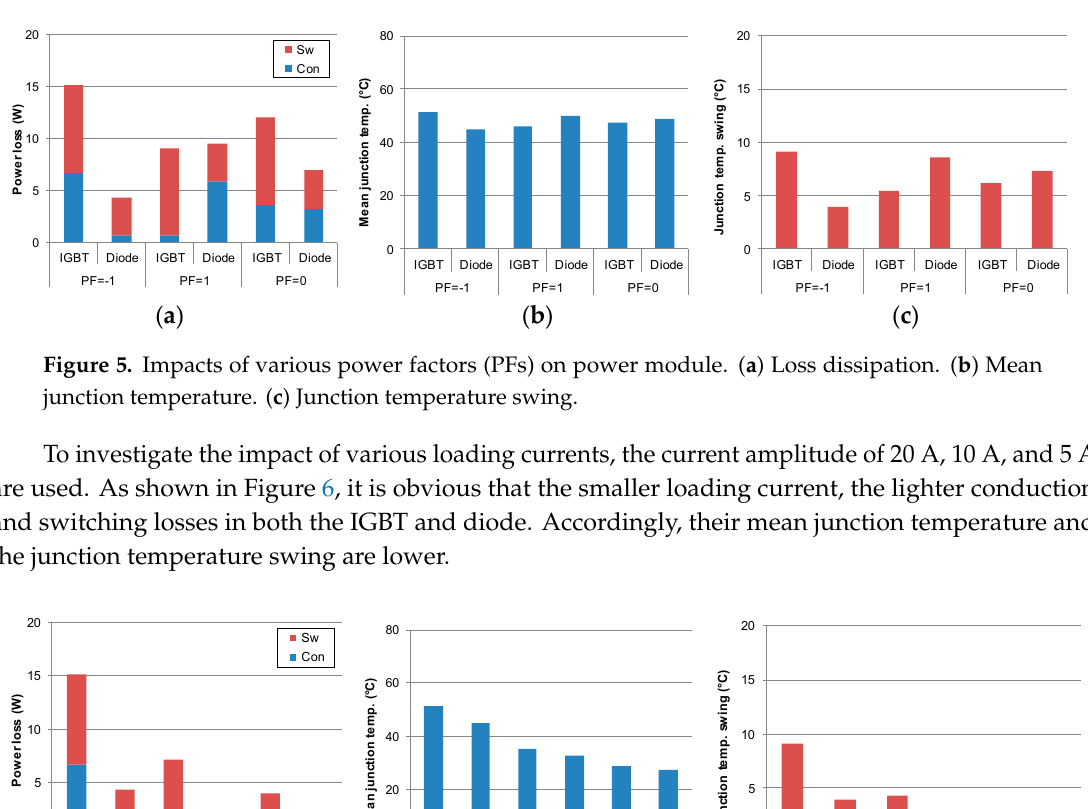
Figure 5. Impacts of various power factors (PFs) on power module. ( a ) Loss dissipation. ( b ) Mean junction temperature. ( c ) Junction temperature swing. Figure 6. Impact of various loading currents (I lo ) on power module. ( a ) Loss dissipation. ( b ) Mean junction temperature. ( c ) Junction temperature swing.